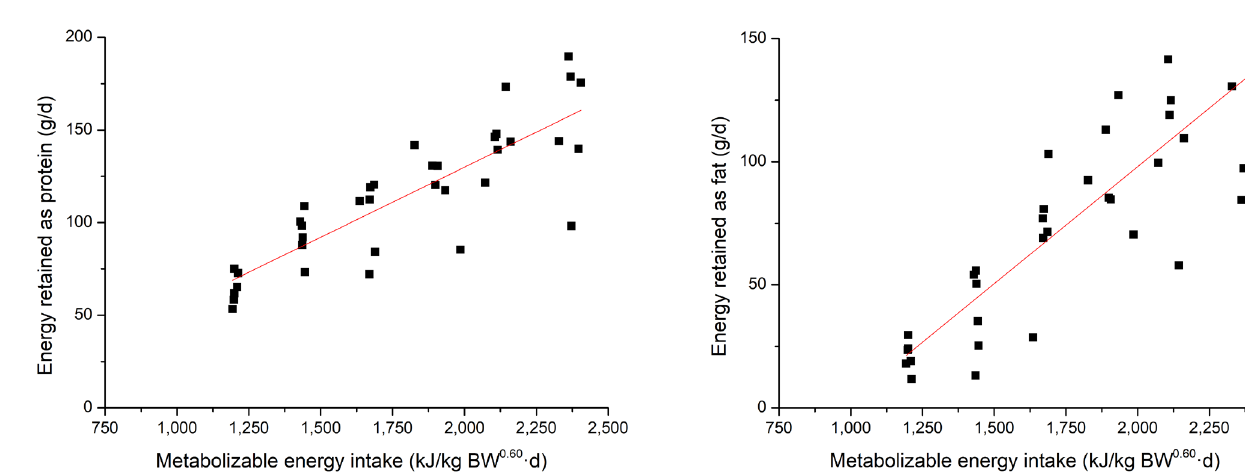
) for all pigs ( ■ ). RE , g/d = 0.095 f f